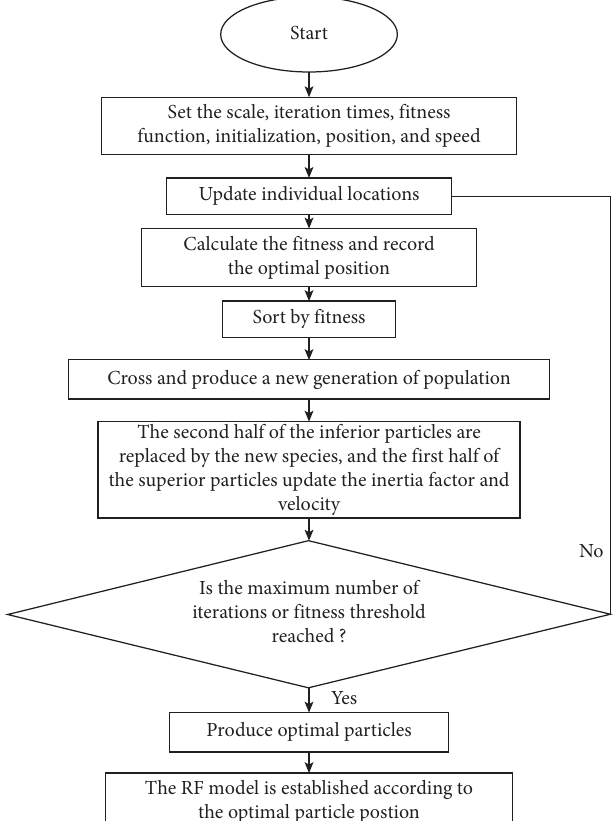
Figure 2: GSA-RFR algorithm procedure.